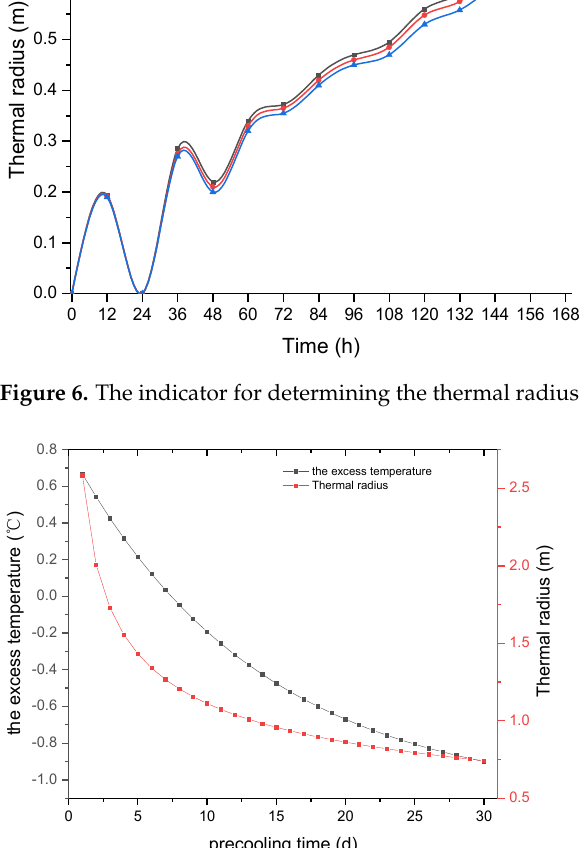
Figure 6. The indicator for determining the thermal radius sensitivity analysis results.